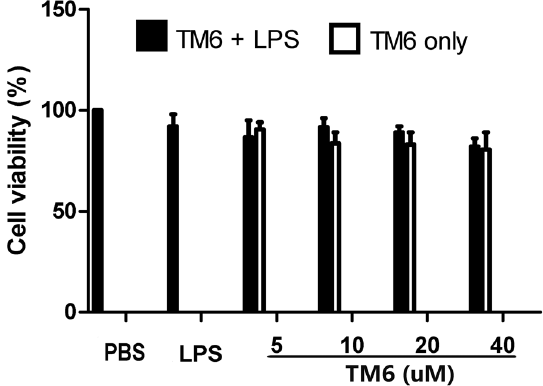
Figure 6. The effect of TM6 on cell viability. Alveolar macrophages extract from mice were treatment with different concentrations of TM6 (0–40 µ M) in the absence or presence LPS (1 µ g/ml) for 24 hours. The cells viability was tested by MTT assay. The values presented are means ± SEM (n = 6). # P < 0.01 is significantly different from the control group; * P < 0.05 and ** P < 0.01 are significantly different from the LPS